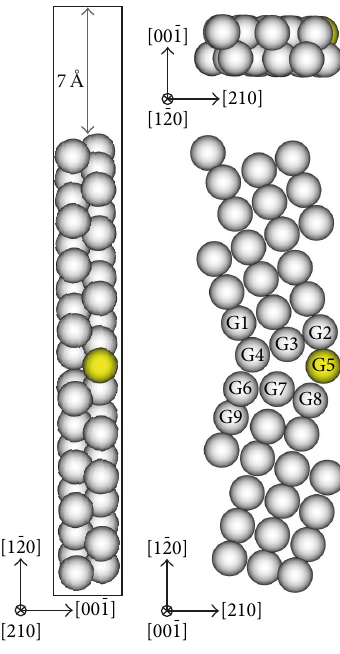
Figure 1: The supercell used in the model calculations of the Σ 5 (210) [100] GB between bcc Cr grains. The yellow sphere indicates the substitutional site used for impurity